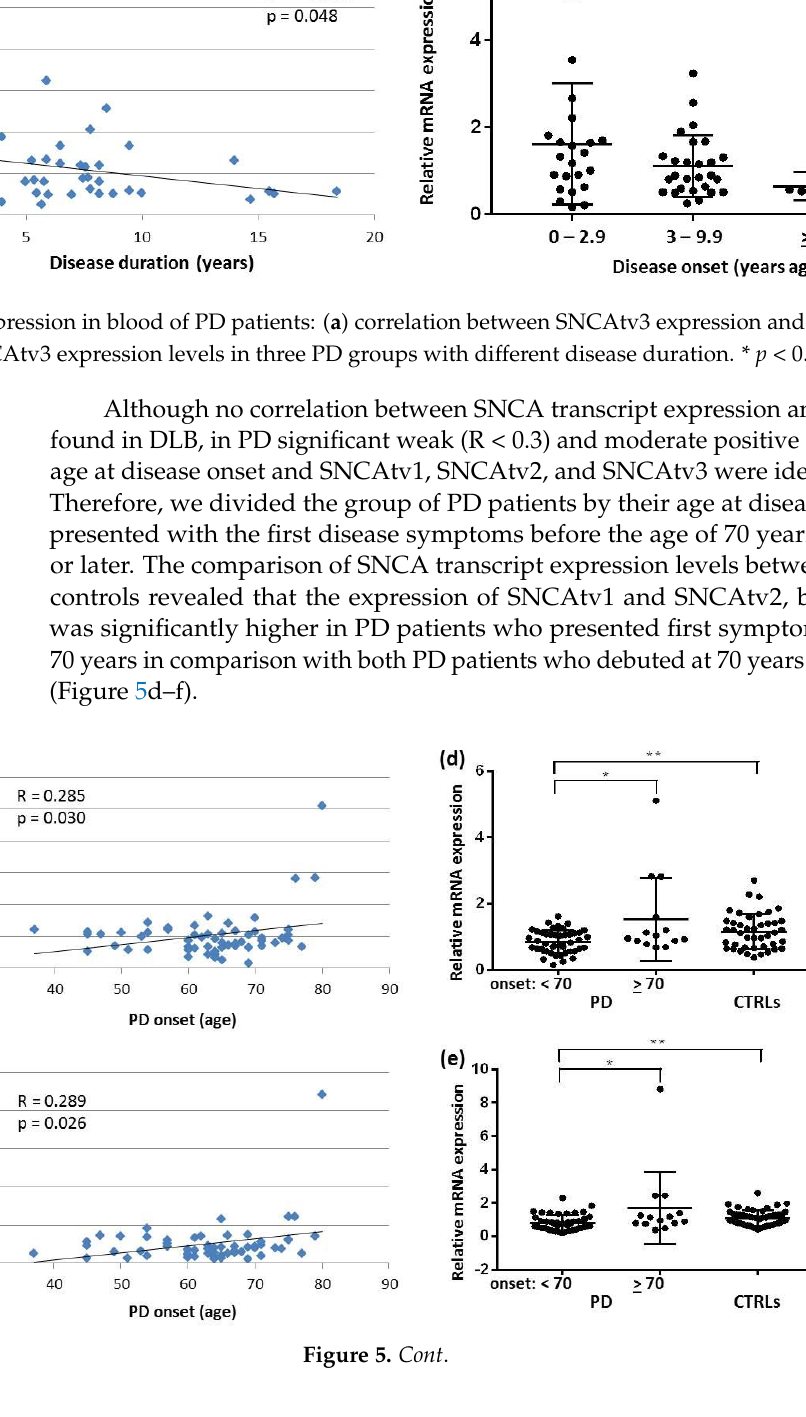
Figure 5. Correlation between the age of PD onset and ( a ) SNCAtv1, ( b ) SNCAtv2, and ( c ) SNCAtv3 expression. SNCA expression in two age-at-onset dependent subgroups compared to controls: ( d ) SNCAtv1; ( e ) SNCAtv2; ( f ) SNCAtv3. * p <0.05, ** p < 0.01. 3. Discussion In the present study we analyzed the expression of five SNCA transcripts in brain and blood of patients diagnosed with DLB or PD. SNCAtv1 was identified as the major SNCA transcript representing between 50 and 60% of total SNCA . The initial exon of SNCAtv2 follows the initial exon of SNCAtv1 without intron in between indicating that both transcripts are partly co-regulated [25]. The initial exon of SNCAtv3 is located about 1 kb up-stream to the other initial exons and therefore, its independent regulation can be expected. Two minor transcripts, SNCA112 lacking exon 5, and SNCA126 lacking exon 3 are generated as the result of in-frame splicing. In the temporal cortex, disease-specific SNCA transcript expression changes were found. Whereas SNCAtv1 was overexpressed in DLB, SNCAtv2 was increased in PD. SNCAtv1 is the major SNCA transcript representing about 50% of overall SNCA mRNA in the temporal cortex, suggesting that the increase of AS and its modified species may be